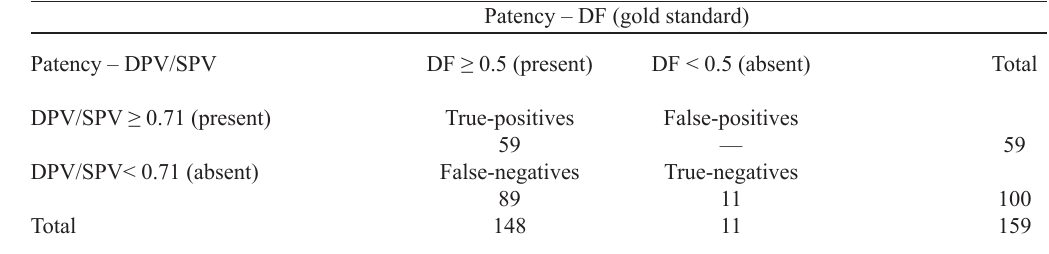
Table 2. Detecting composite graft patency (present or absent) using DPV/SPV, with DF as the gold standard. Data obtained from 38